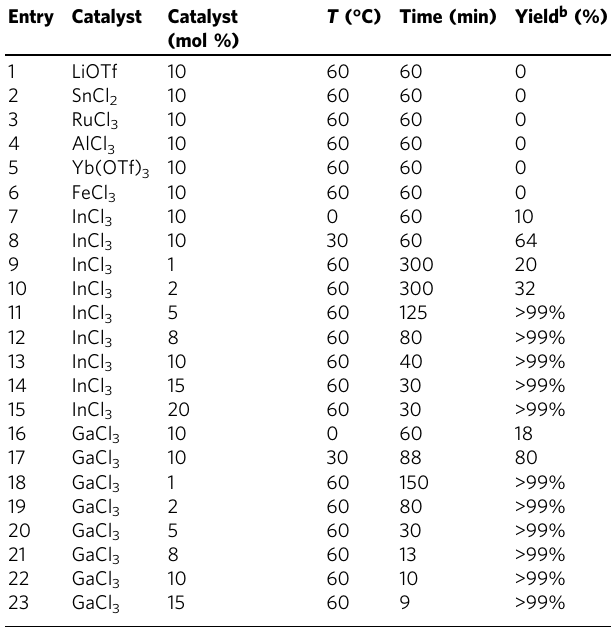
a Reactions were performed with using ITIC-CHO and IC with a molar ratio of 1: 2; b The yields were determined by 1 H NMR spectroscopy (400MHz) with toluene-d 8 as an internal standard and